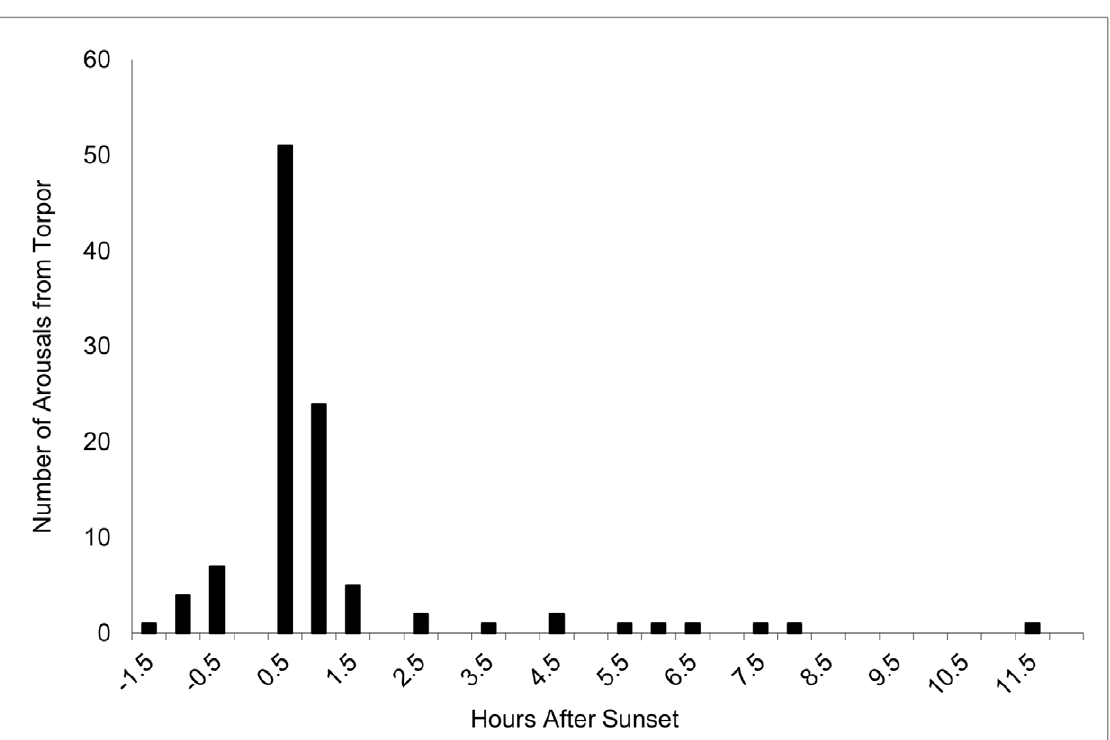
Figure 3. Timing of periodic arousals from hibernation in relation to sunset determined through radio-telemetry at Mammoth Cave National Park, Kentucky, USA.